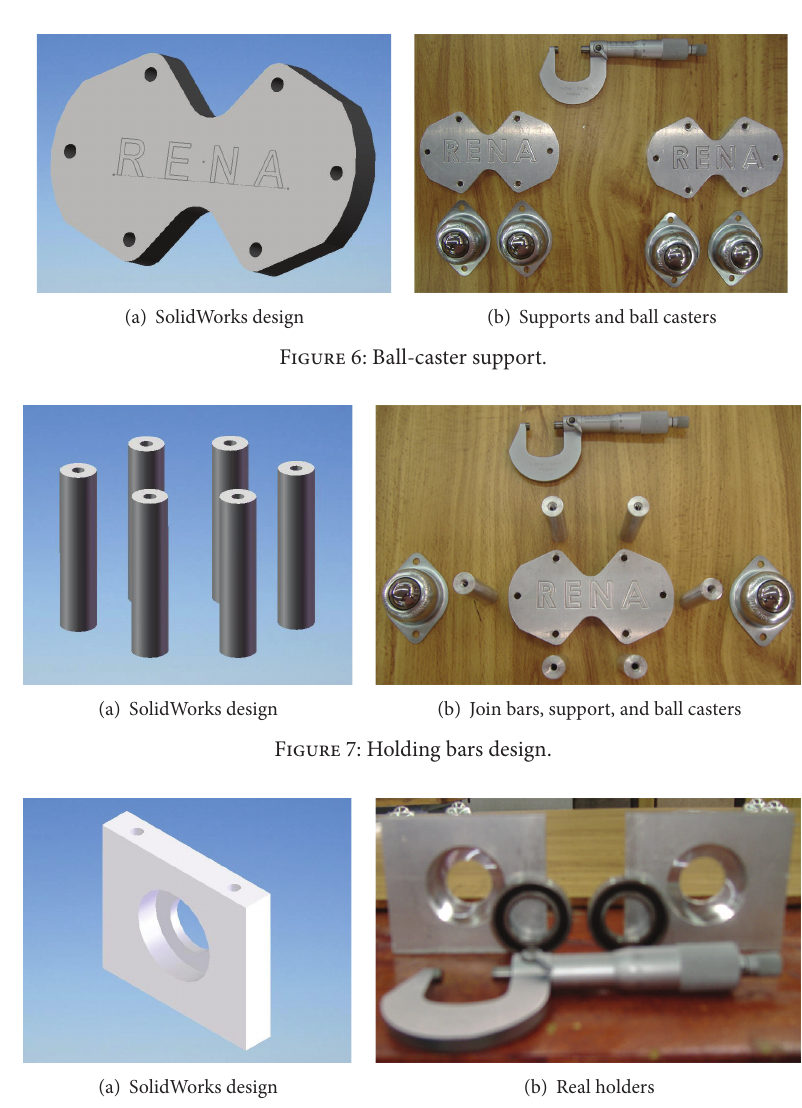
Figure 8: Ball-bearing